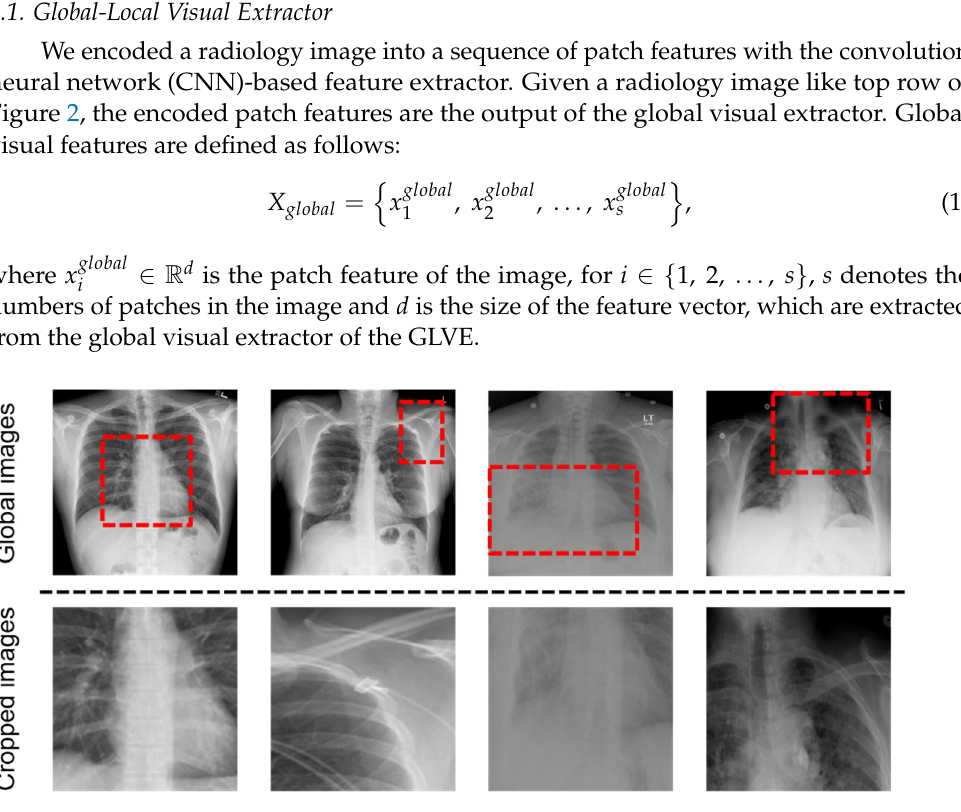
Figure 2. Example of input images of the GLVE. ( Top ): Global Radiology images, the input of the global visual extractor. We used a dashed box to indicate the region to be cropped. ( Bottom ): Cropped and resized images from corresponding images, used as the input of the local visual extractor.